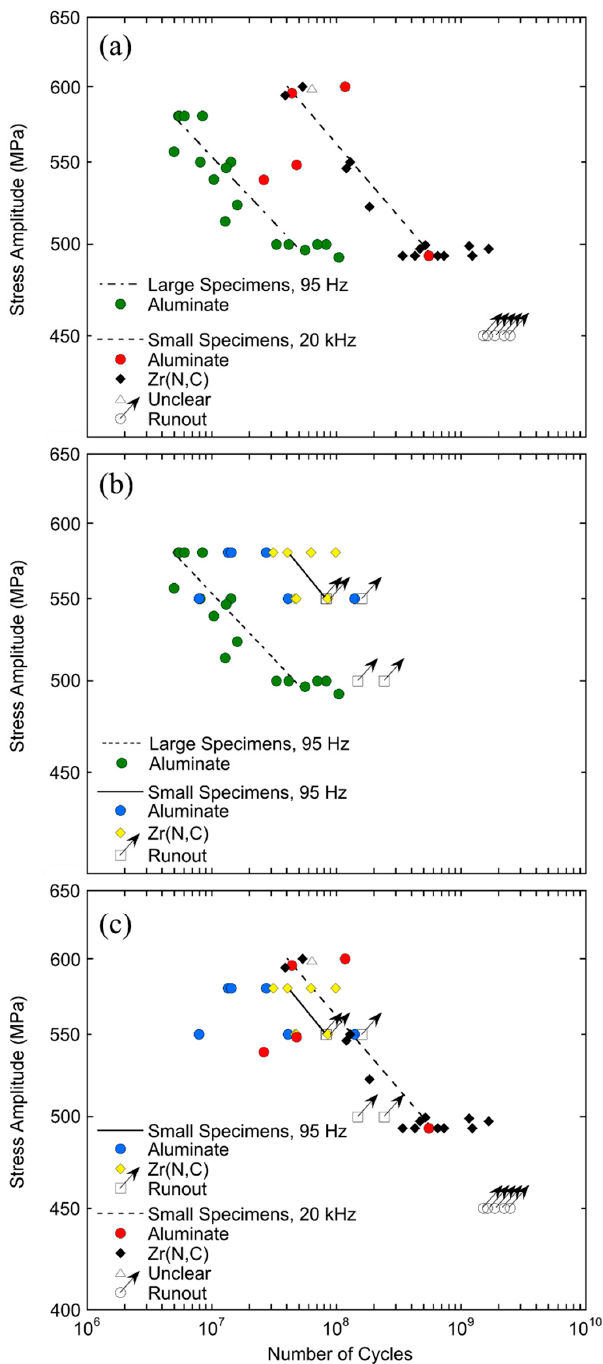
Figure 6. Comparison of S-N data at load ratio R = 0.1 ( a ) of large specimens tested at 95 Hz and of small specimens tested at 20 kHz; ( b ) of large and small specimens tested at 95 Hz; ( c ) of small specimens tested at 95 Hz and 20 kHz; crack initiation was at internal aluminate inclusions (circles) or at internal Zr(N,C) inclusions (diamonds); runouts are marked with arrows; reprinted with permission from Elsevier [16].